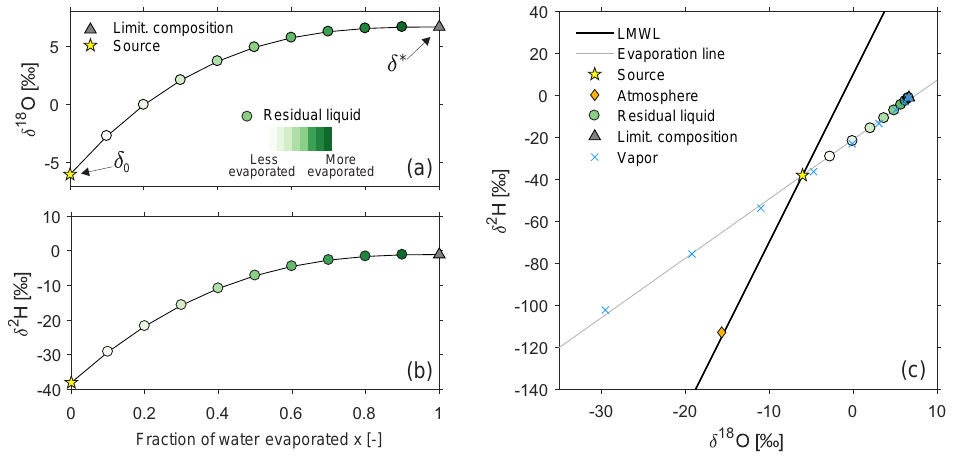
Figure 2. Introductory example showing the evolution of the isotopic composition of residual water δ L for the case of an isolated volume of precipitation that evaporates into the atmosphere. The initial composition (source water) δ 0 = δ P is − 6‰ (for δ 18 O) and − 38‰ (for δ 2 H). (a) and (b) show the oxygen and hydrogen isotopic composition for increasing fractions of evaporation (decreasing fraction of residual liquid) as they approach the limiting composition, while (c) shows the same isotope effects in a dual isotope